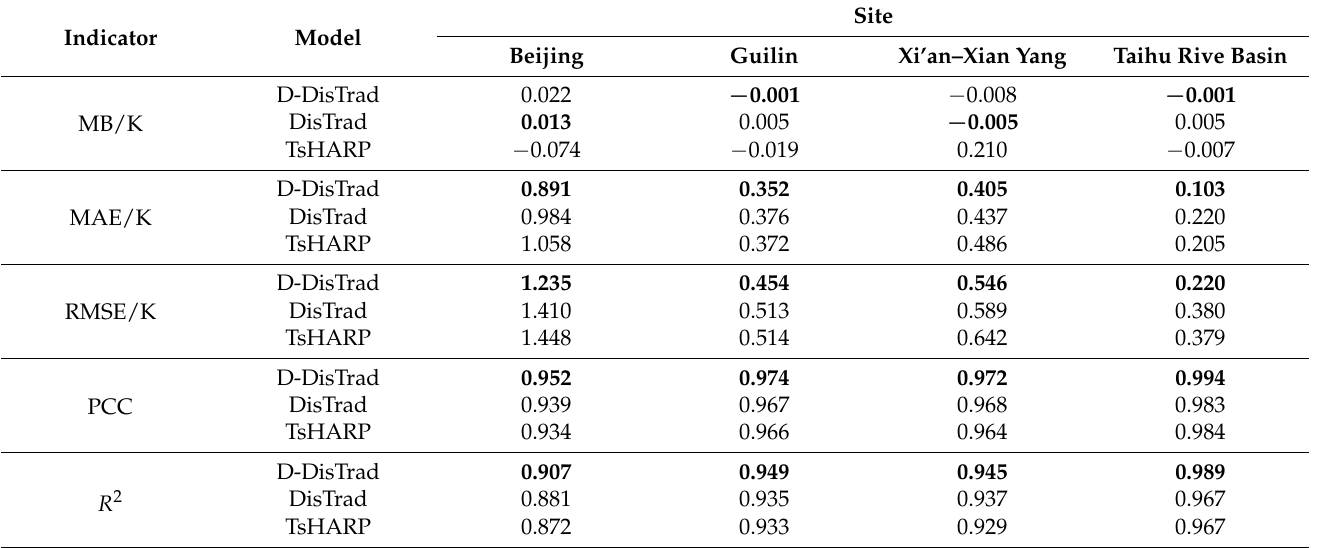
Table 5. Statistics for the three downscaling results aggregating to 900 m in comparison with the SLSTR LST data for the 4